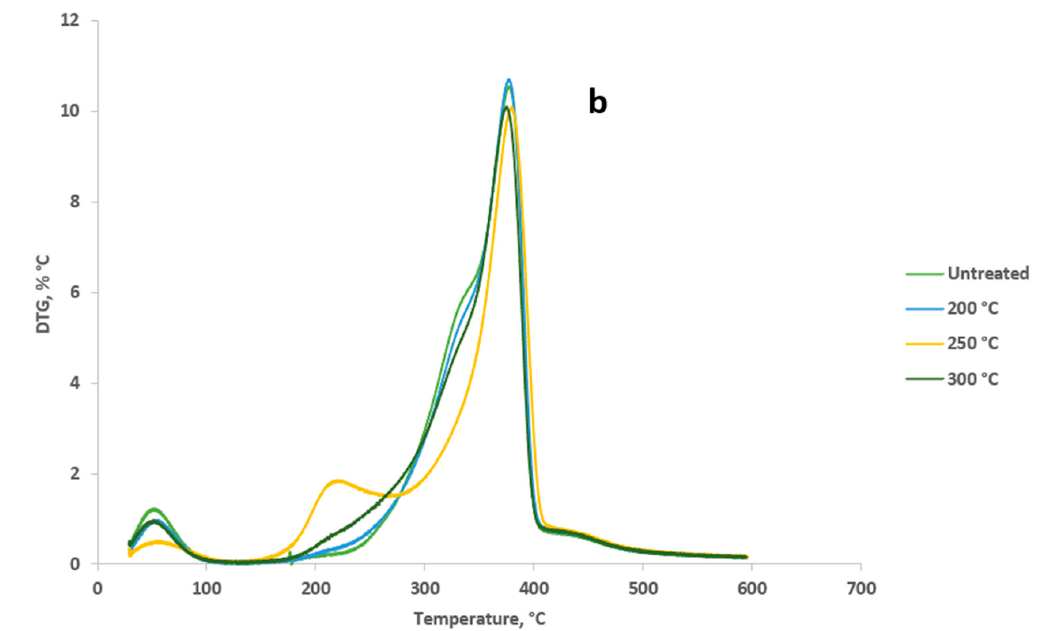
Figure 11. The DTG analysis graph of the raw and torrefied WSS: ( a ) thermogravimetry curves of the untreated and torrefied WSS; ( b ) differential thermogravimetry curves of the untreated, torre- fied